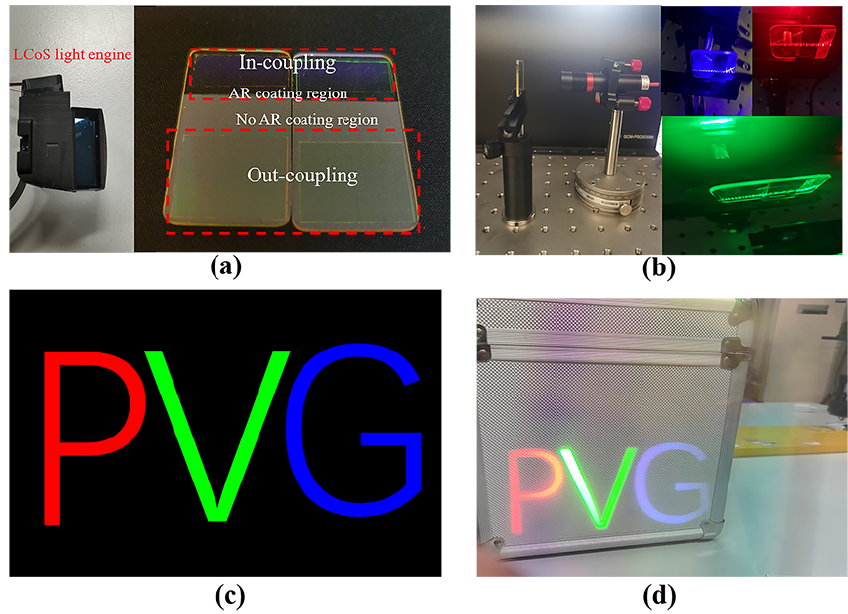
Figure 8. ( a ) Waveguide physical diagram. ( b ) Coupling propagation capability of the prepared PVG waveguides for 457 nm, 532 nm, and 630 nm laser incident beams. ( c ) Input image. ( d ) Output image.